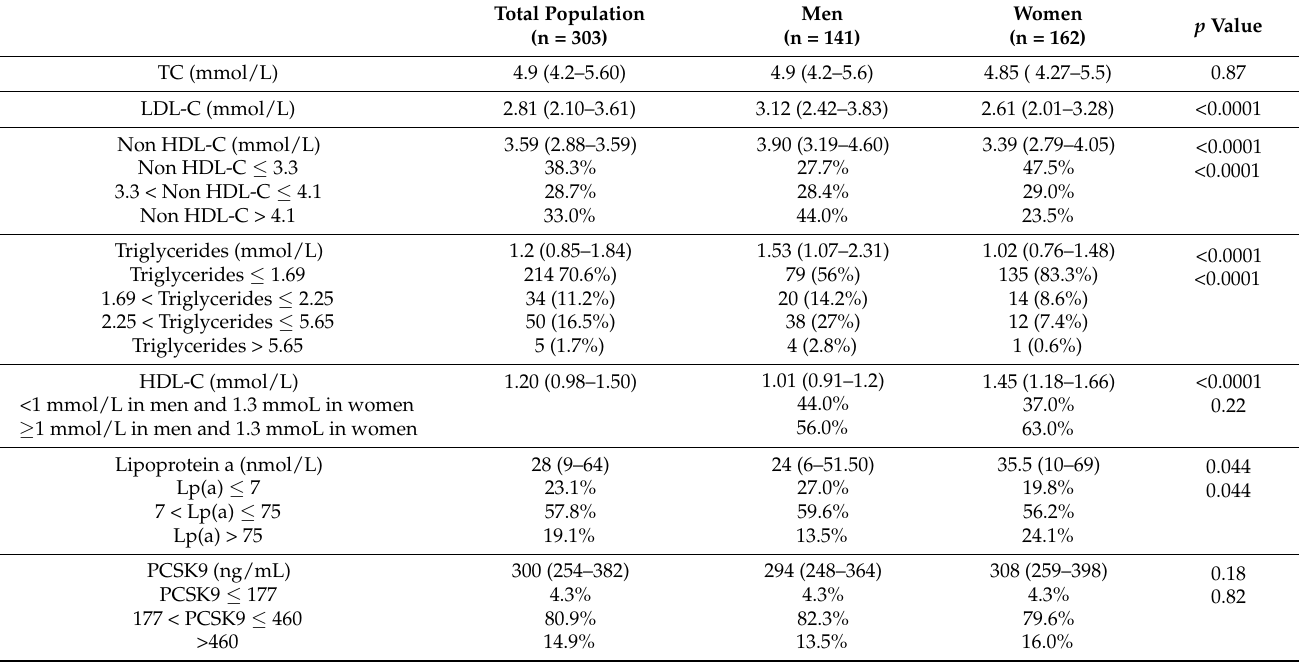
Table 2. Lipid profile, Lp(a), and PCSK9 in the entire population and in men and women.